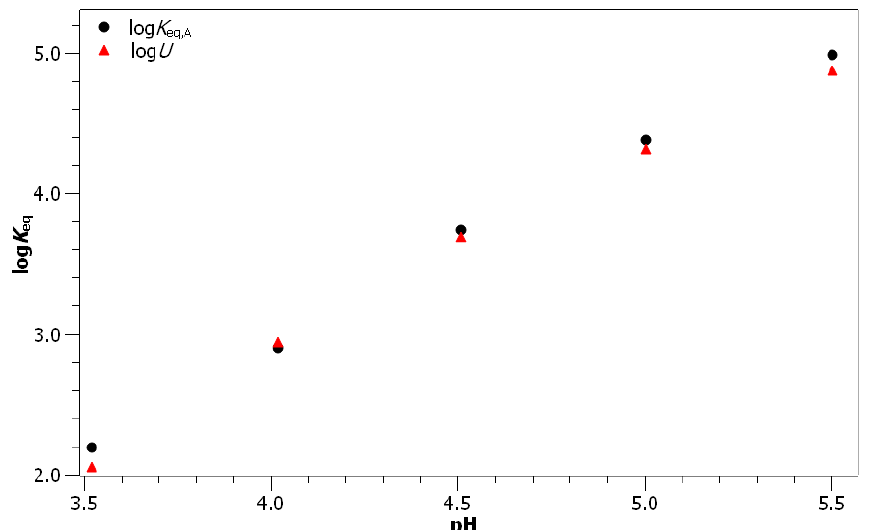
Figure 7. Dependence of log( K eq,A ) and log( U [H ) values on the pH. The only significant 2 GAFe] difference between the values occurs at pH 5.50, where, however, the experimental error of K eq,A is quite big. See Figure S13 for the depiction with the estimated fitting